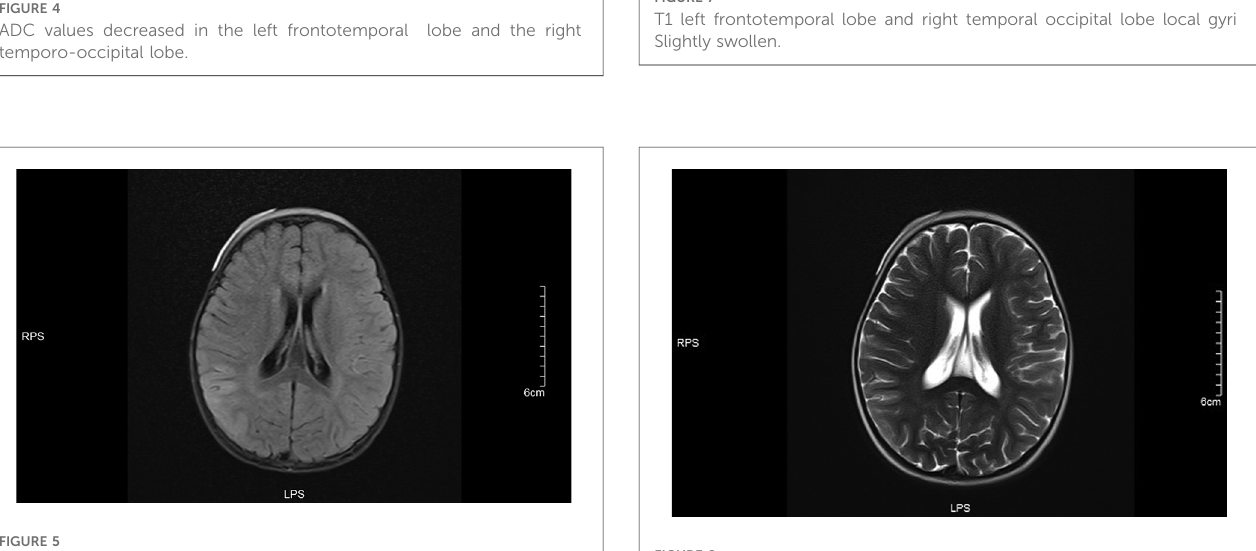
FIGURE 8 No signi fi cant abnormality was observed in T2 sequence